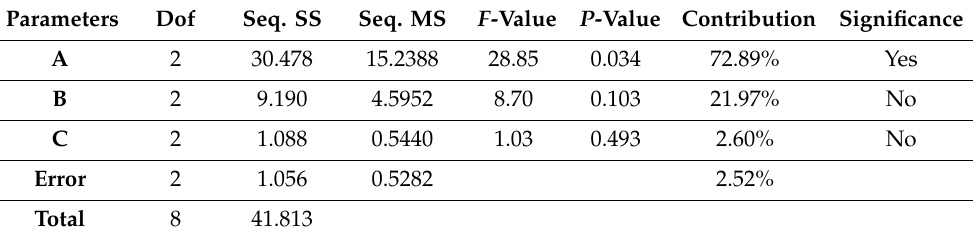
Table 3. Results of ANOVA tests for tensile